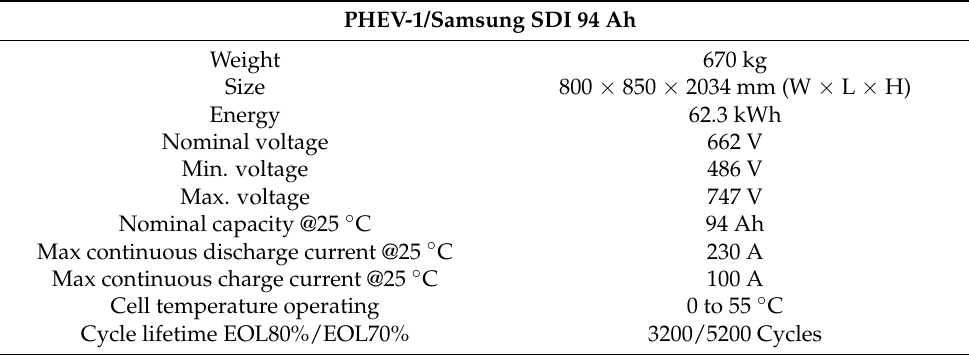
Table 3. Technical specifications of the reference battery for the